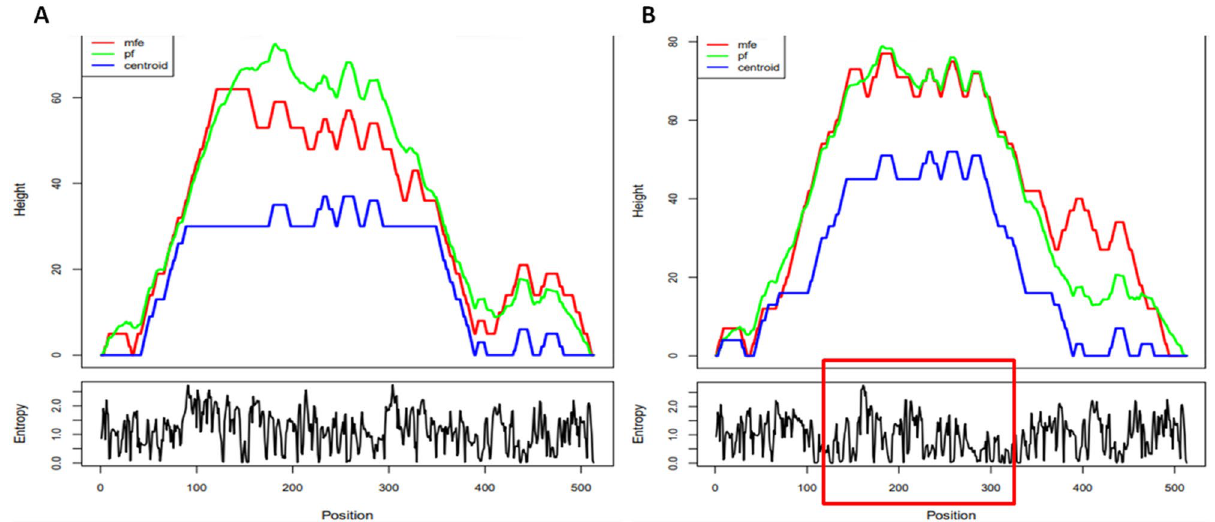
Figure 7. The impact of nsSNPs on the mRNA secondary structure properties was predicted by the RNAfold server. ( A ) RNAfold generated Mountain plot (minimum free energy, Partition function folding and centroid structure) curves for non-mutated BBD129 -TA haplotype mRNA. ( B ) RNAfold generated a Mountain plot of double mutated BBD129 -GG haplotype mRNA. The BBD129 nsSNPs impacted the minimum free energy of mRNA secondary structure by influencing base-pairing properties and entropy.